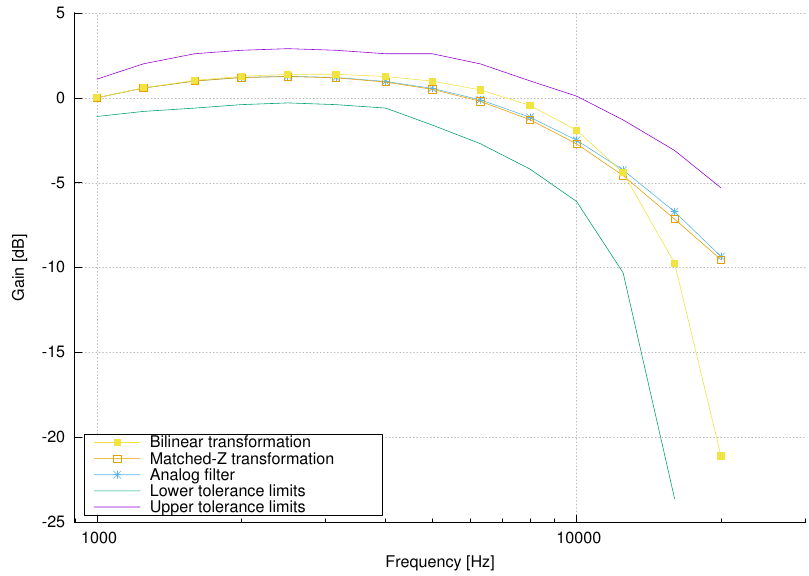
Figure 6. Enlarged portion of the magnitude responses of digital and analog A-weighting filters in the frequency range above 1